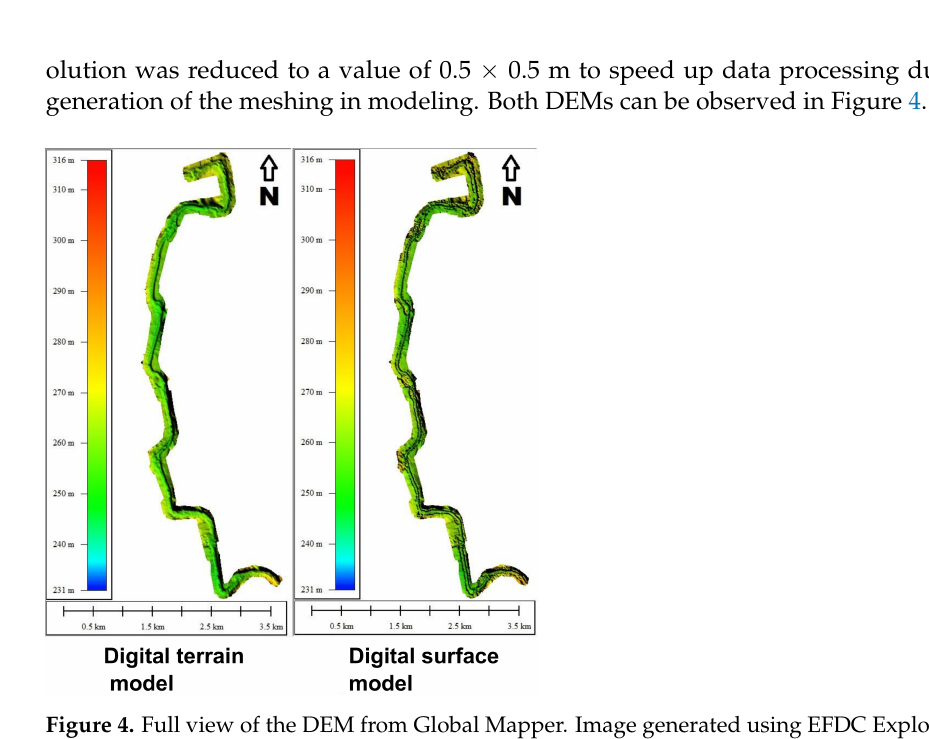
Figure 4. Full view of the DEM from Global Mapper. Image generated using EFDC Explorer.